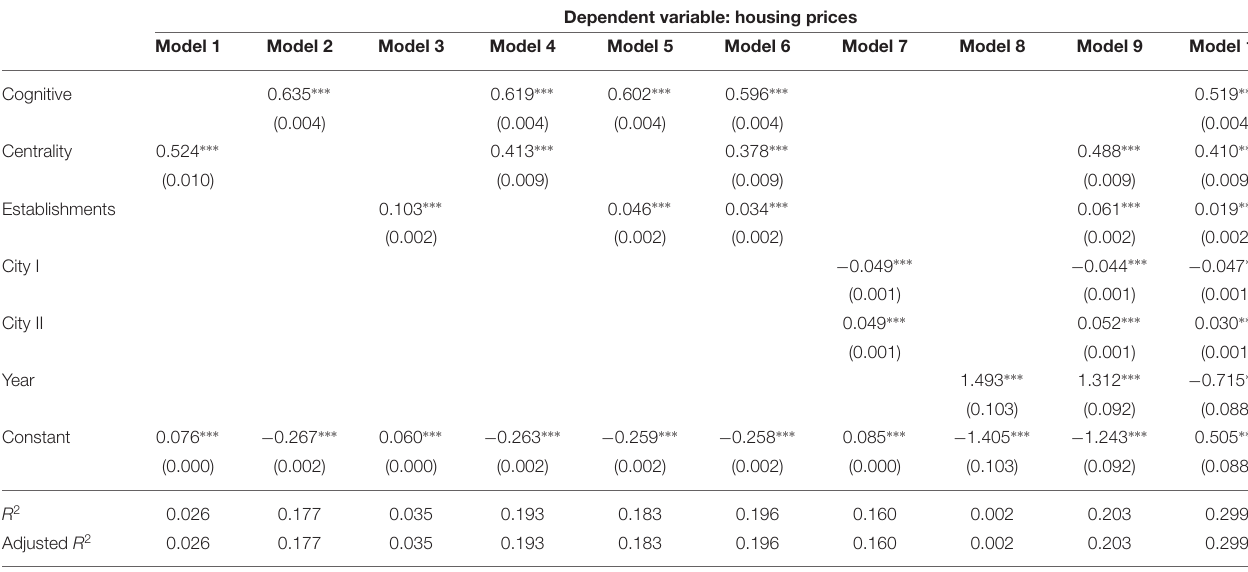
TABLE 2 | Depending on cognitive skills, ordinary least squares (OLS) regression estimates the housing